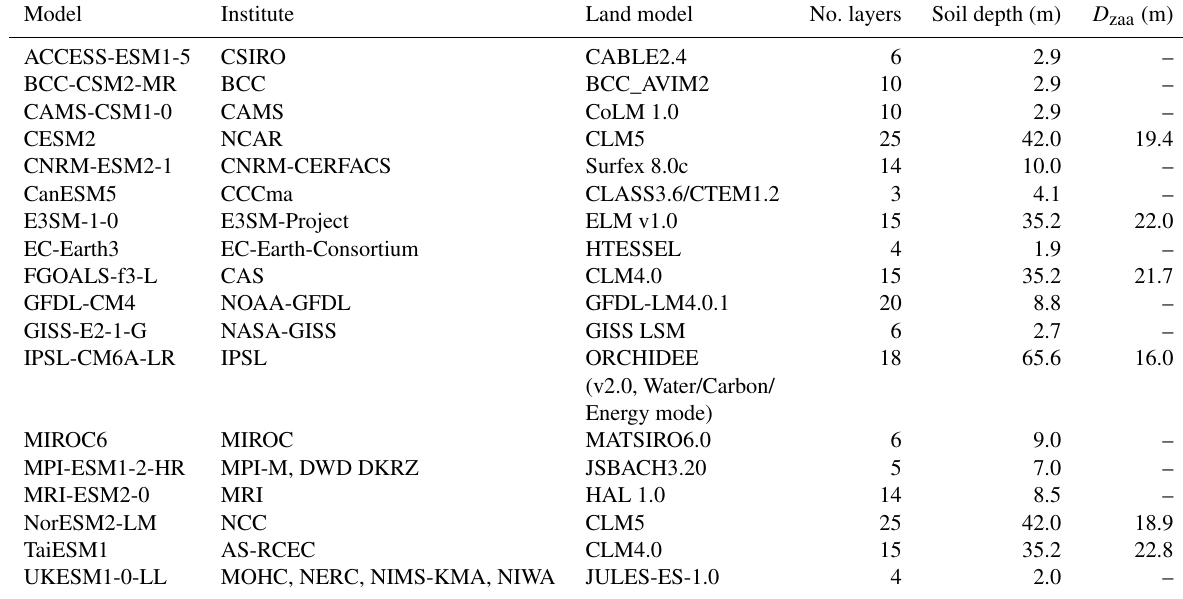
Table 1. A summary of the CMIP6 models used in this study including the number of soil layers and the depth of the middle of the bottom soil layer. Also show is D zaa for the models where the difference in the annual maximum and minimum soil temperatures at the maximum soil depth is less than 0.1 ◦ C. CMIP5 models are summarised in Table